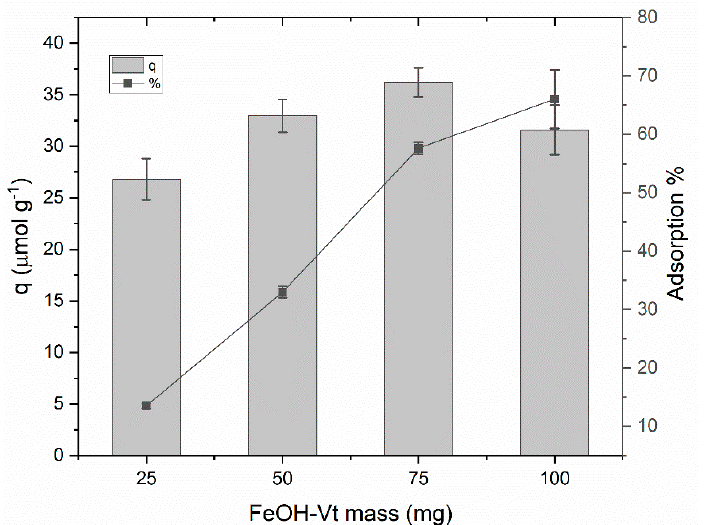
Figure 4. Dose effect investigation adopting a contact time of 200 min, initial phosphate concentration of 4.84 × 10 2 μ mol·L − 1 (15 mg·L − 1 in P) and 25.0 ± 0.5